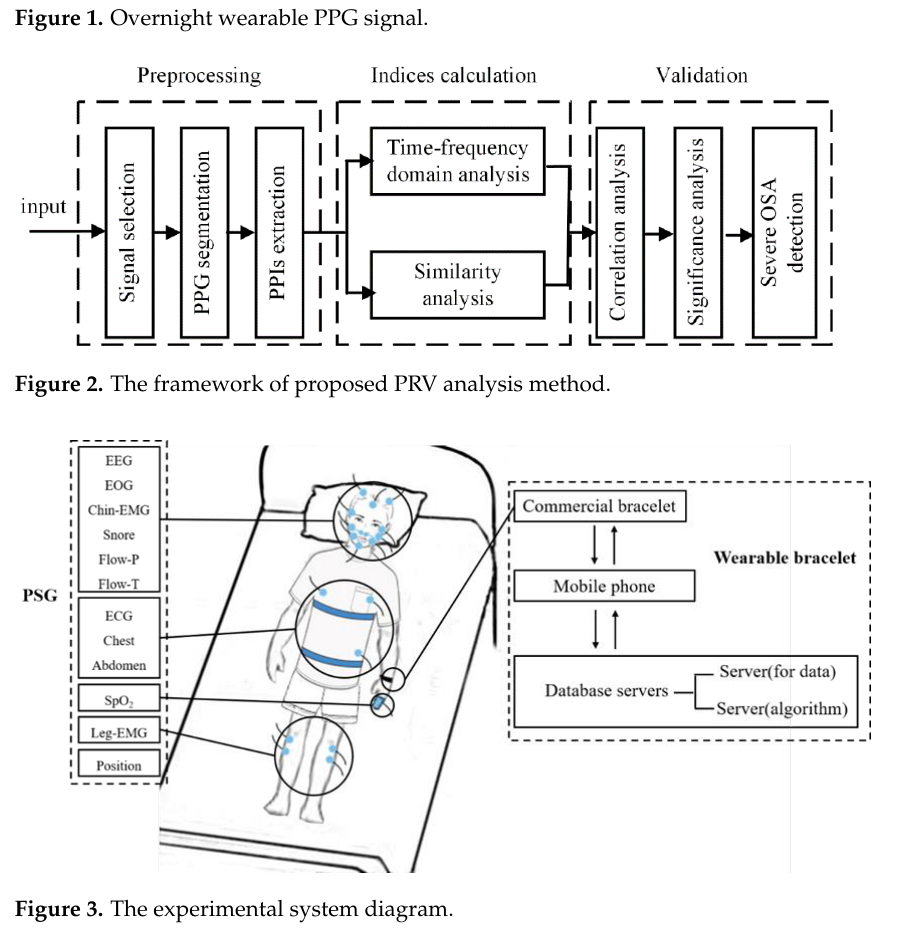
Figure 1. Overnight wearable PPG signal.